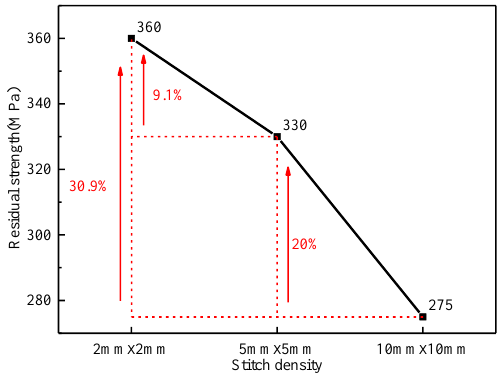
Figure 12. The predicted residual strengths with different stitched densities.